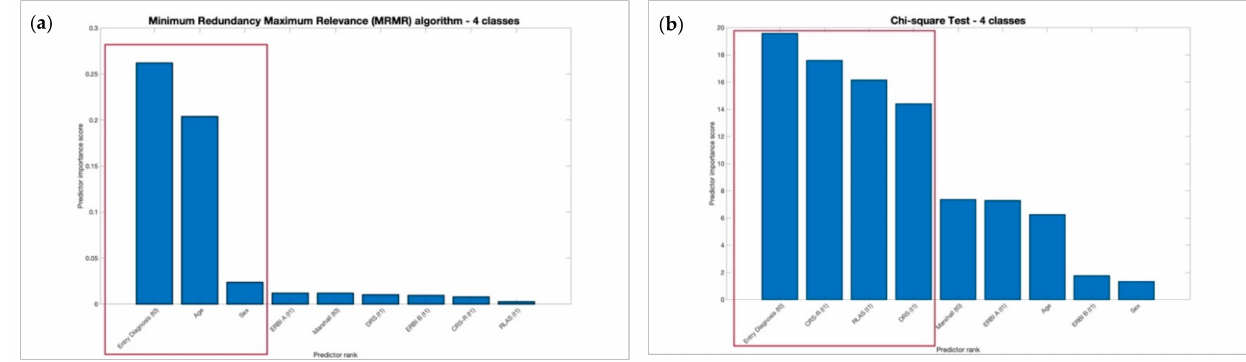
Figure 2. Most significant features selected using 4 classes of outcome, respectively, using MRMR and Chi-Square selection